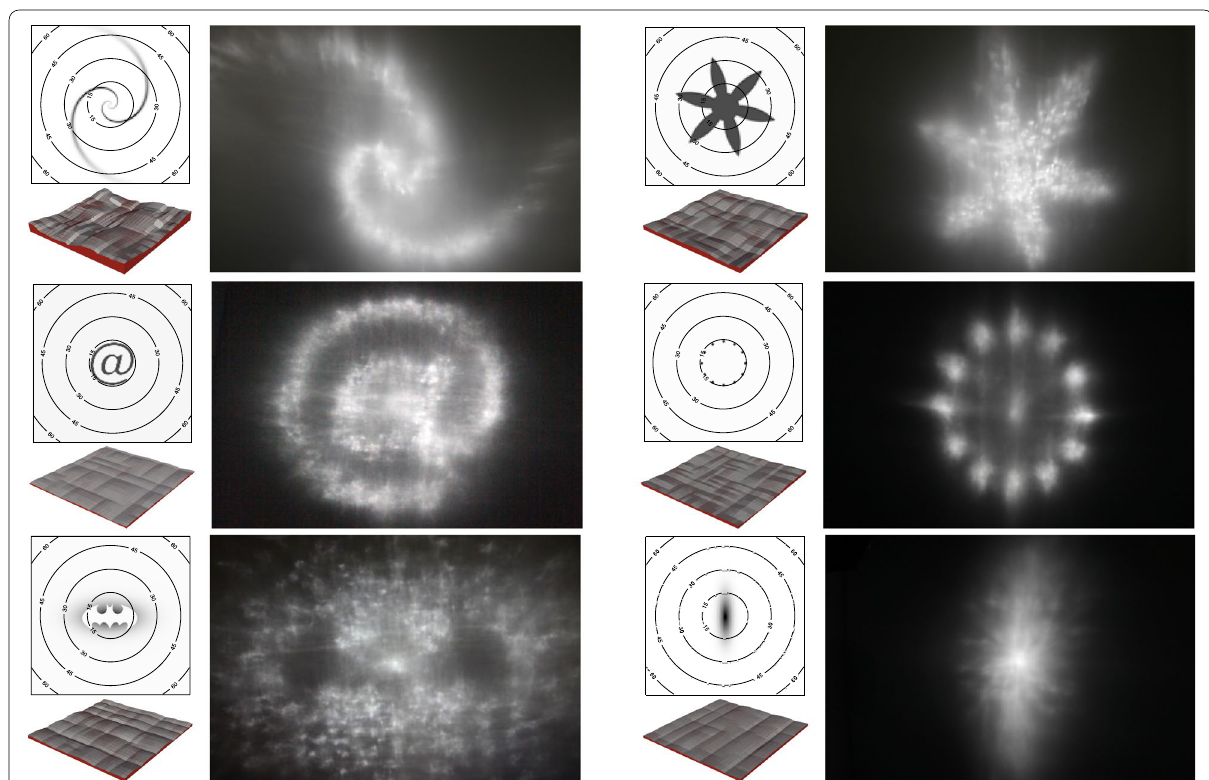
Fig. 10 Six results of Weyrich et al.[17] manufactured using CNC. Top‑left is the target distribution. Bottom‑left is the object and right is the reflected